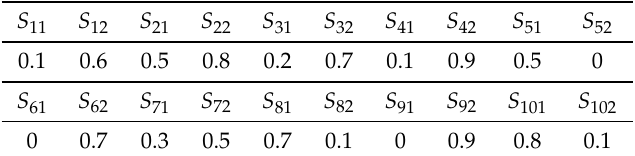
Table 3. Logarithms of the priority factors of the sensors.